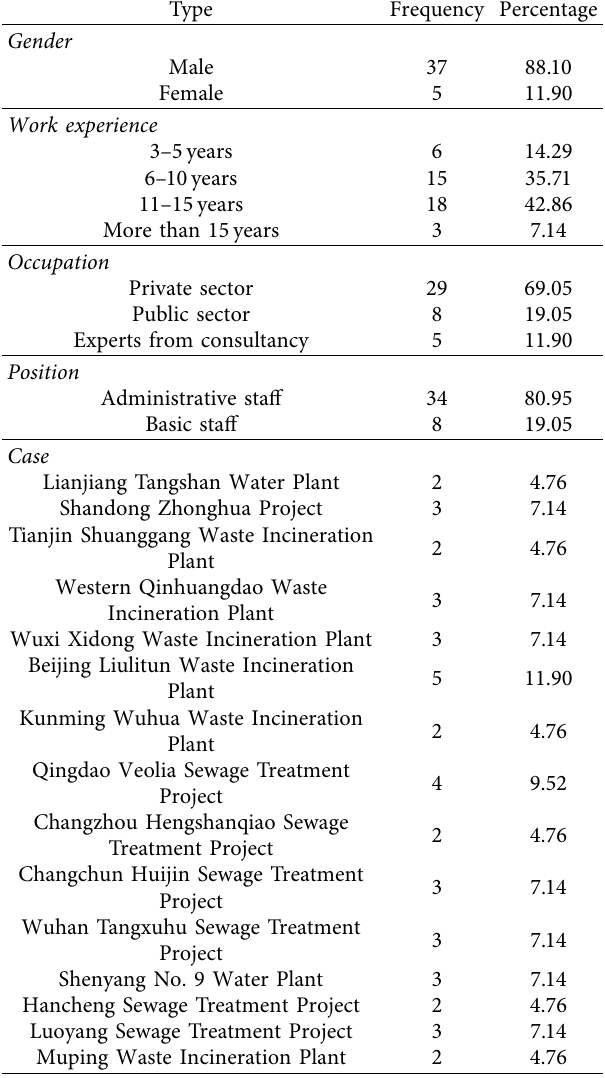
Table 4: Respondent